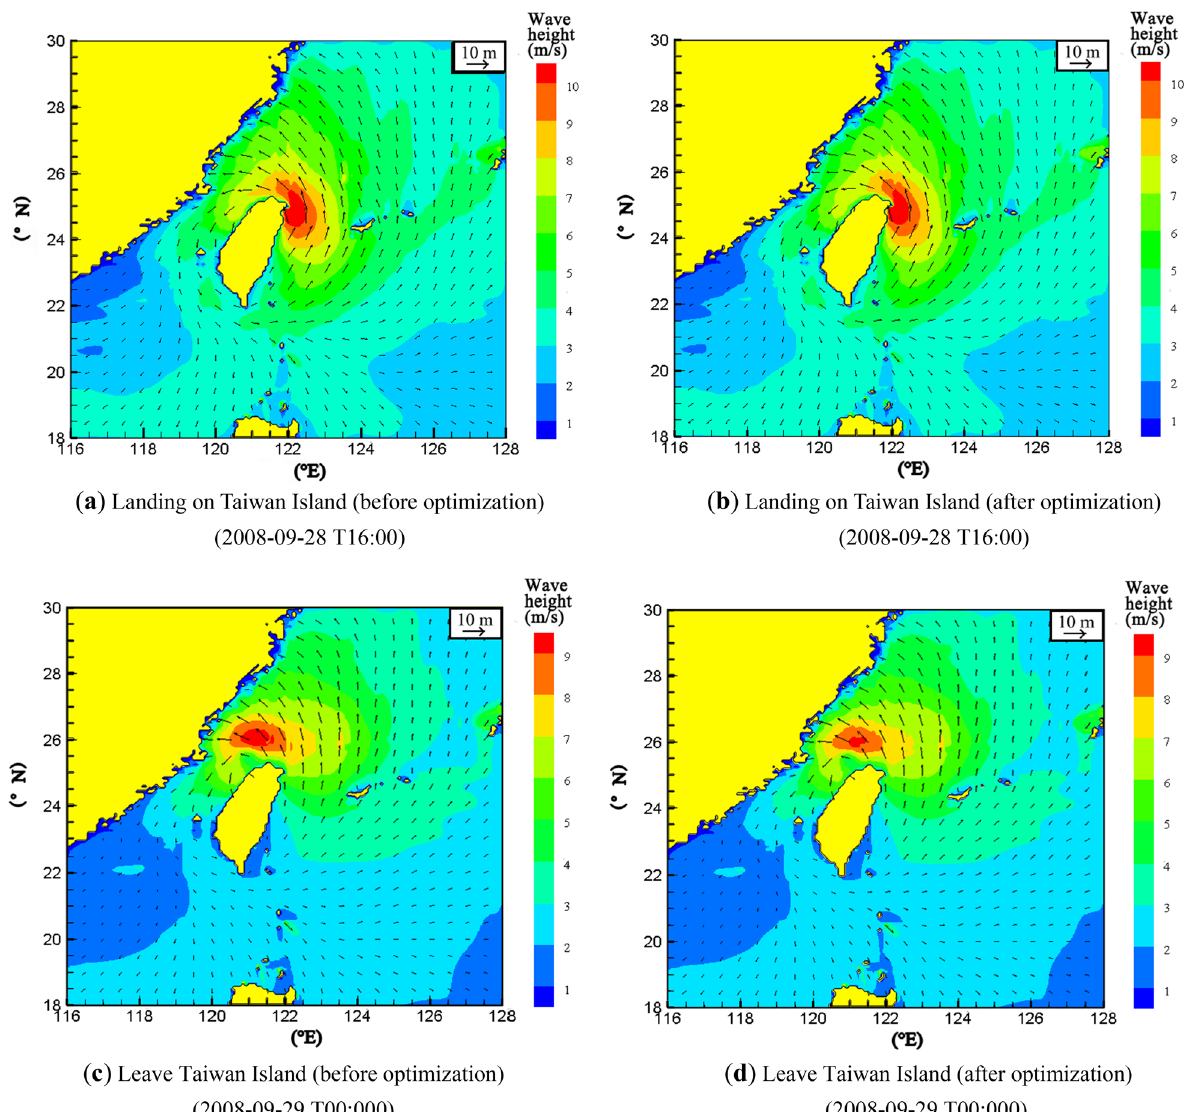
Fig. 10 The distribution of wind speed and significant wave height before and after optimization of typhoon Jiangmi when it landed (2008-09-28 T16:00) and left Taiwan (2008-09-29